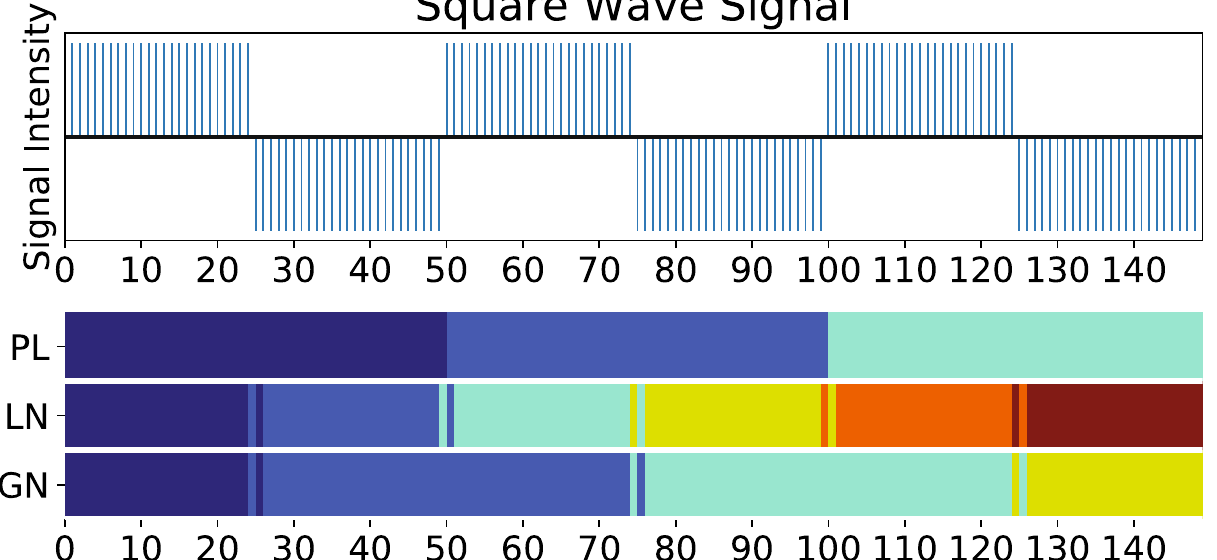
Figure 2. The intensity and communities of cosine (top) and square wave (bottom) signal time series. The communities obtained by our method (PL), Louvain method (LN) and Girvan–Newman method (GN) are represented with color bars, with time points in the same community having the same color. The communities obtained with our automated method on both cosine and square wave time series are capturing the signal periods. The Louvain method captures the characteristics of the square wave signal but shows temporal timepoint mixing in communities on the cosine signal. The Girvan–Newman method captures the periods of the two time series with some errors at the